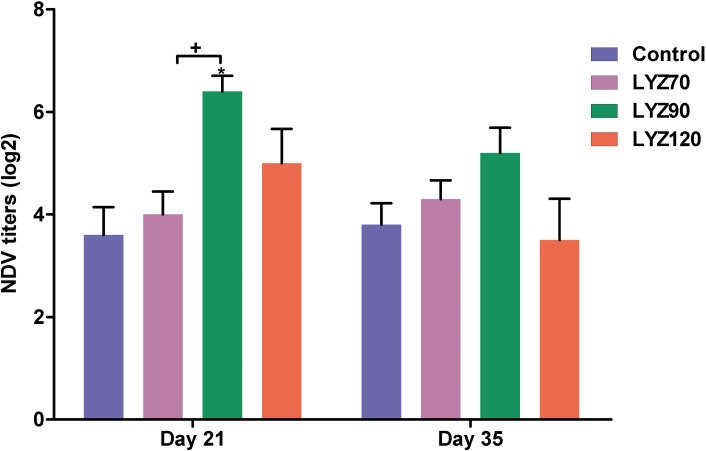
Hemagglutination inhibition (HI) titer for Newcastle disease vaccine (NDV).*P < 0.05 vs. control and +P < 0.05 vs. LYZ90. Statistical analysis was done by One-way ANOVA, Tukey’s post hoc test multiple comparisons. Error bars represent SE.